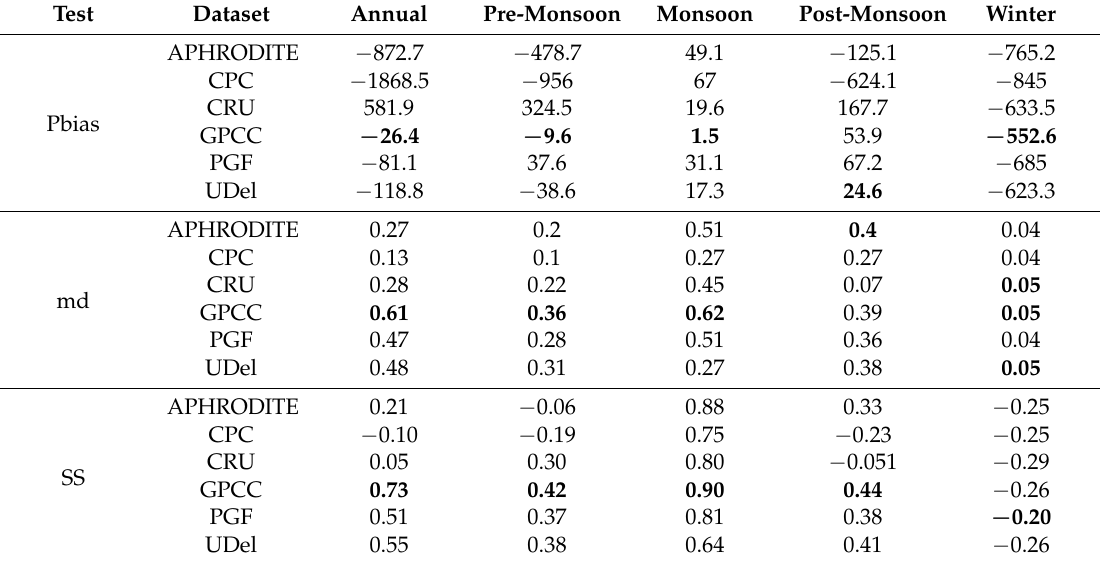
Table 5. The results of the statistical indices used to assess the spatial similarity in changes (Sen’s slope) obtained using different gridded datasets for annual and seasonal rainfall during 1979–2010. The best scores obtained for different seasons are highlighted using bold